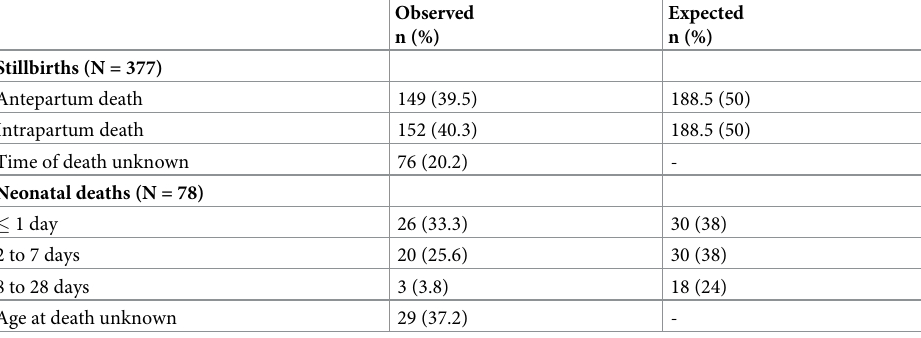
Table 3. Stillbirths and neonatal deaths identified using PN RAPID in two facilities in Nepal.